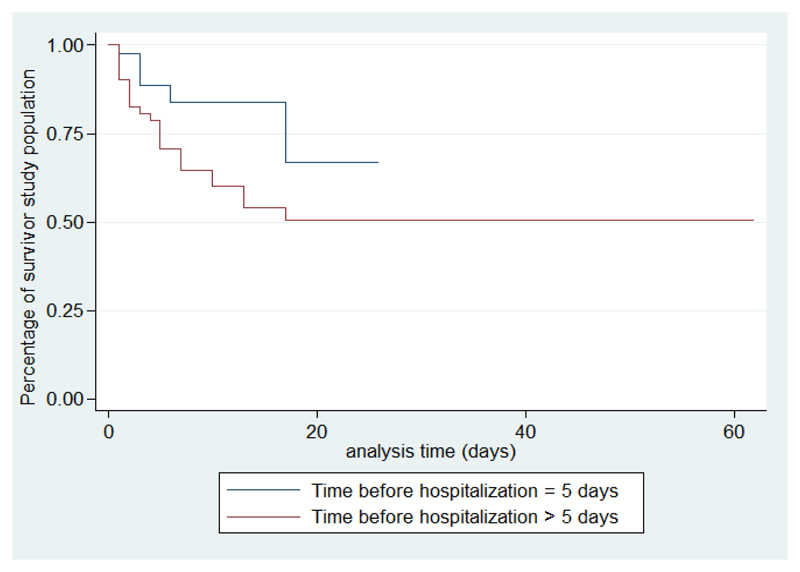
Survival analysis curves according to time before hospitalization